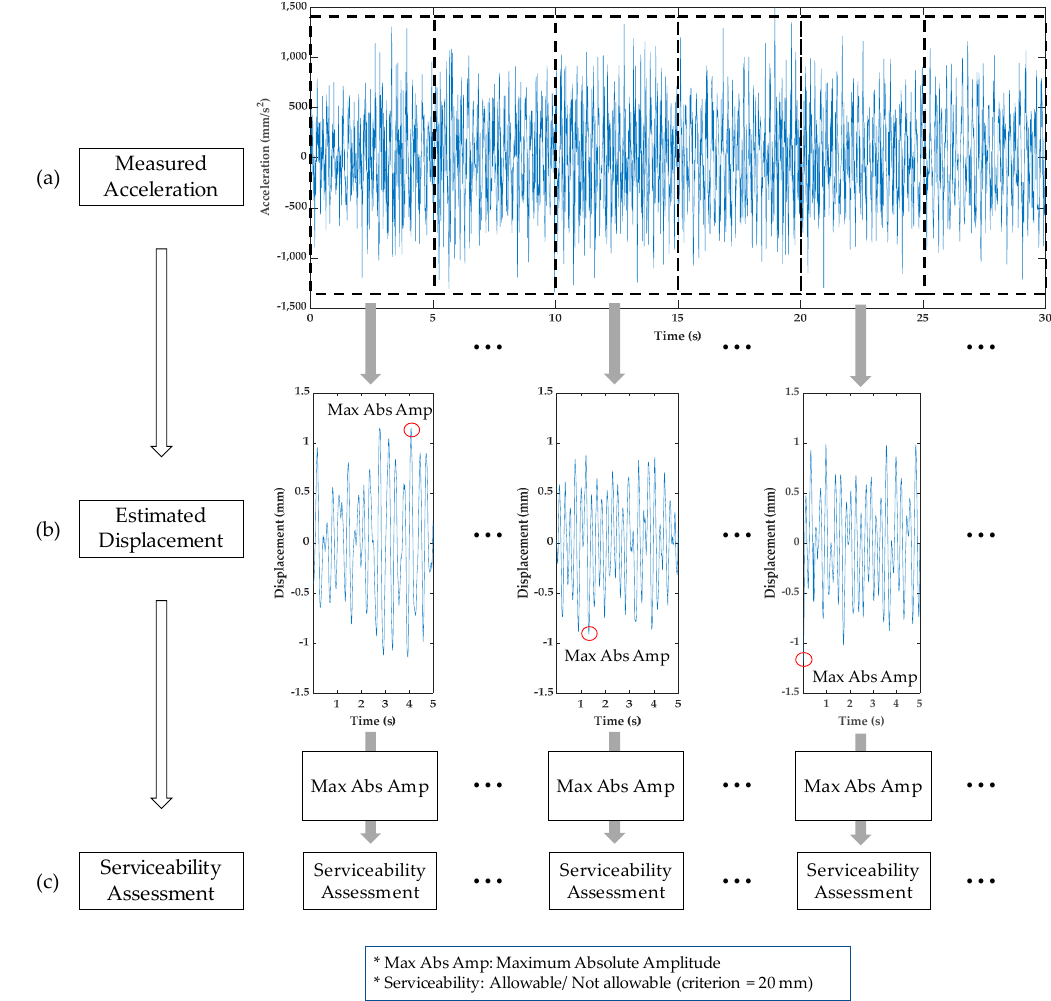
Figure 5. Automated real-time serviceability assessment results for 30 s .